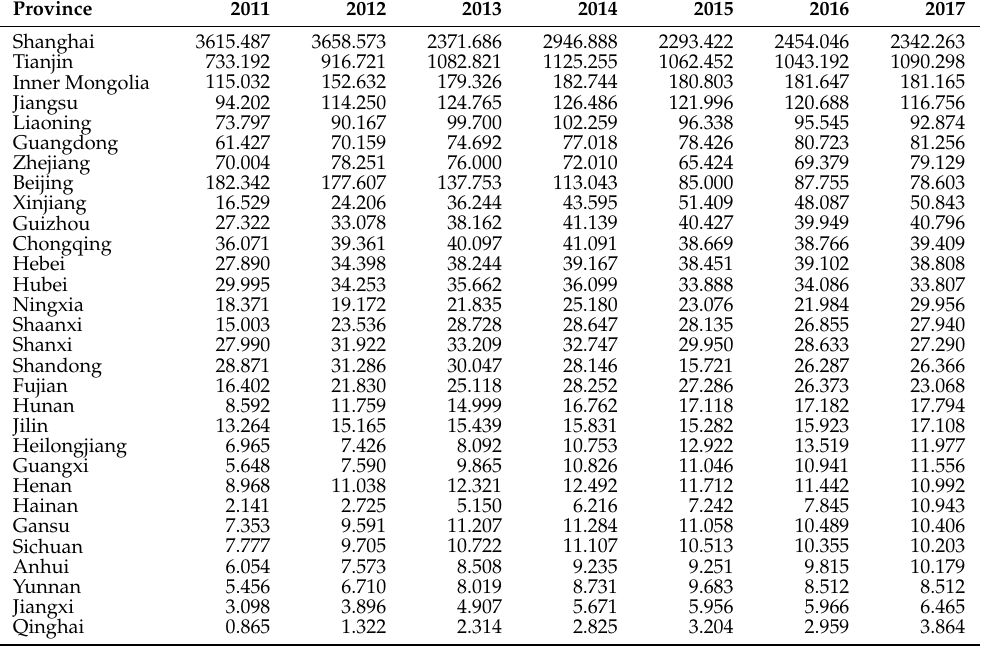
Table A6. The intra-provincial carbon inequality estimation results of original carbon emission data based on a 3-year rolling window for 30 provinces in China from 2011 to